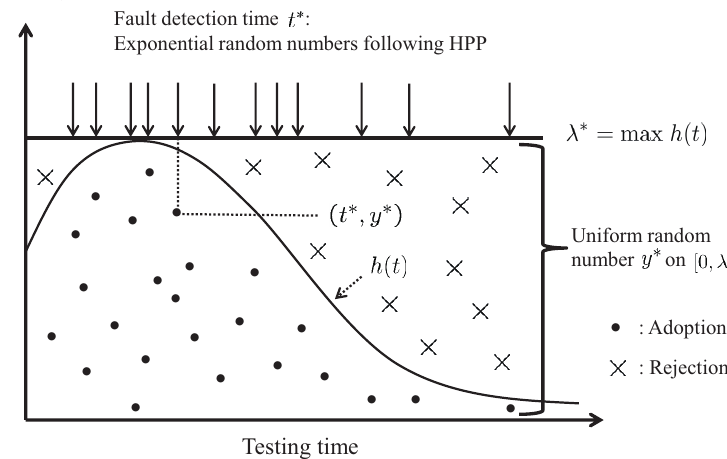
Figure 1. Conceptual figure of the thinning